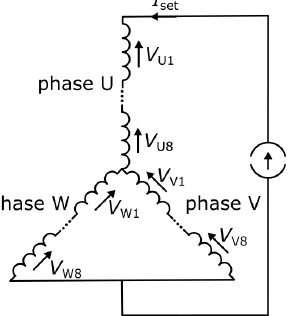
Figure 6. Phase connection to emulate worst-case loss distribution.